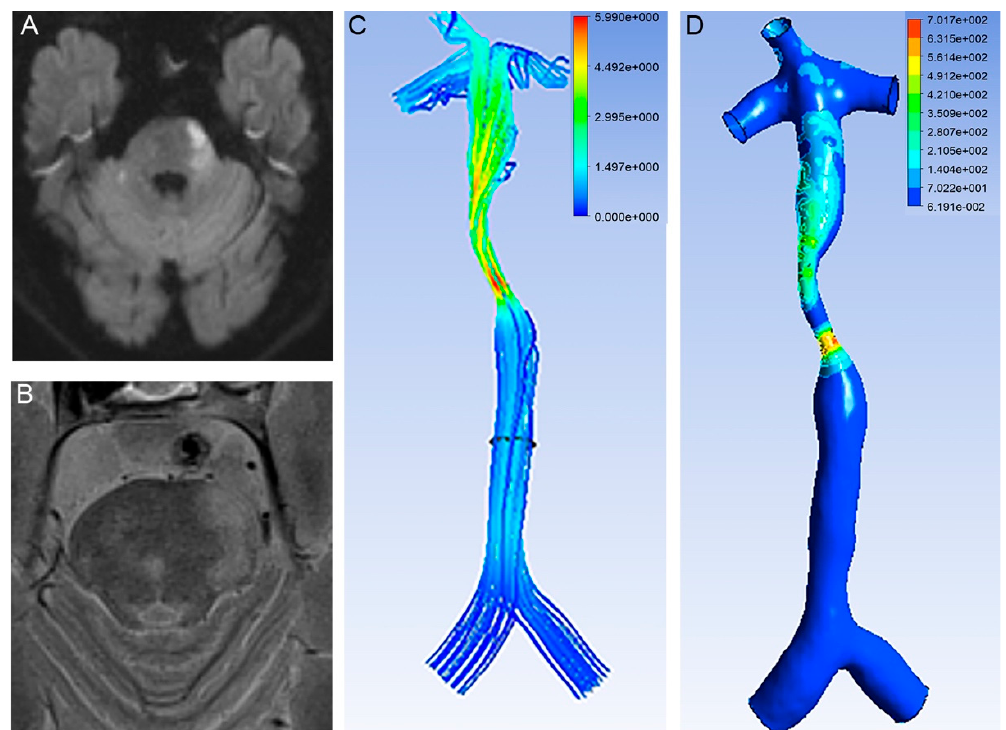
Figure 3. Higher proximal WSS related with stroke. ( A ) DWI showed an infarction located in the pontine. ( B ) T2 images of HR MRI showed RFC. ( C ) Velocity of BA. ( D ) WSS of BA. Proximal WSS was 7.34 Pa and stenotic WSS was 559.51 Pa.